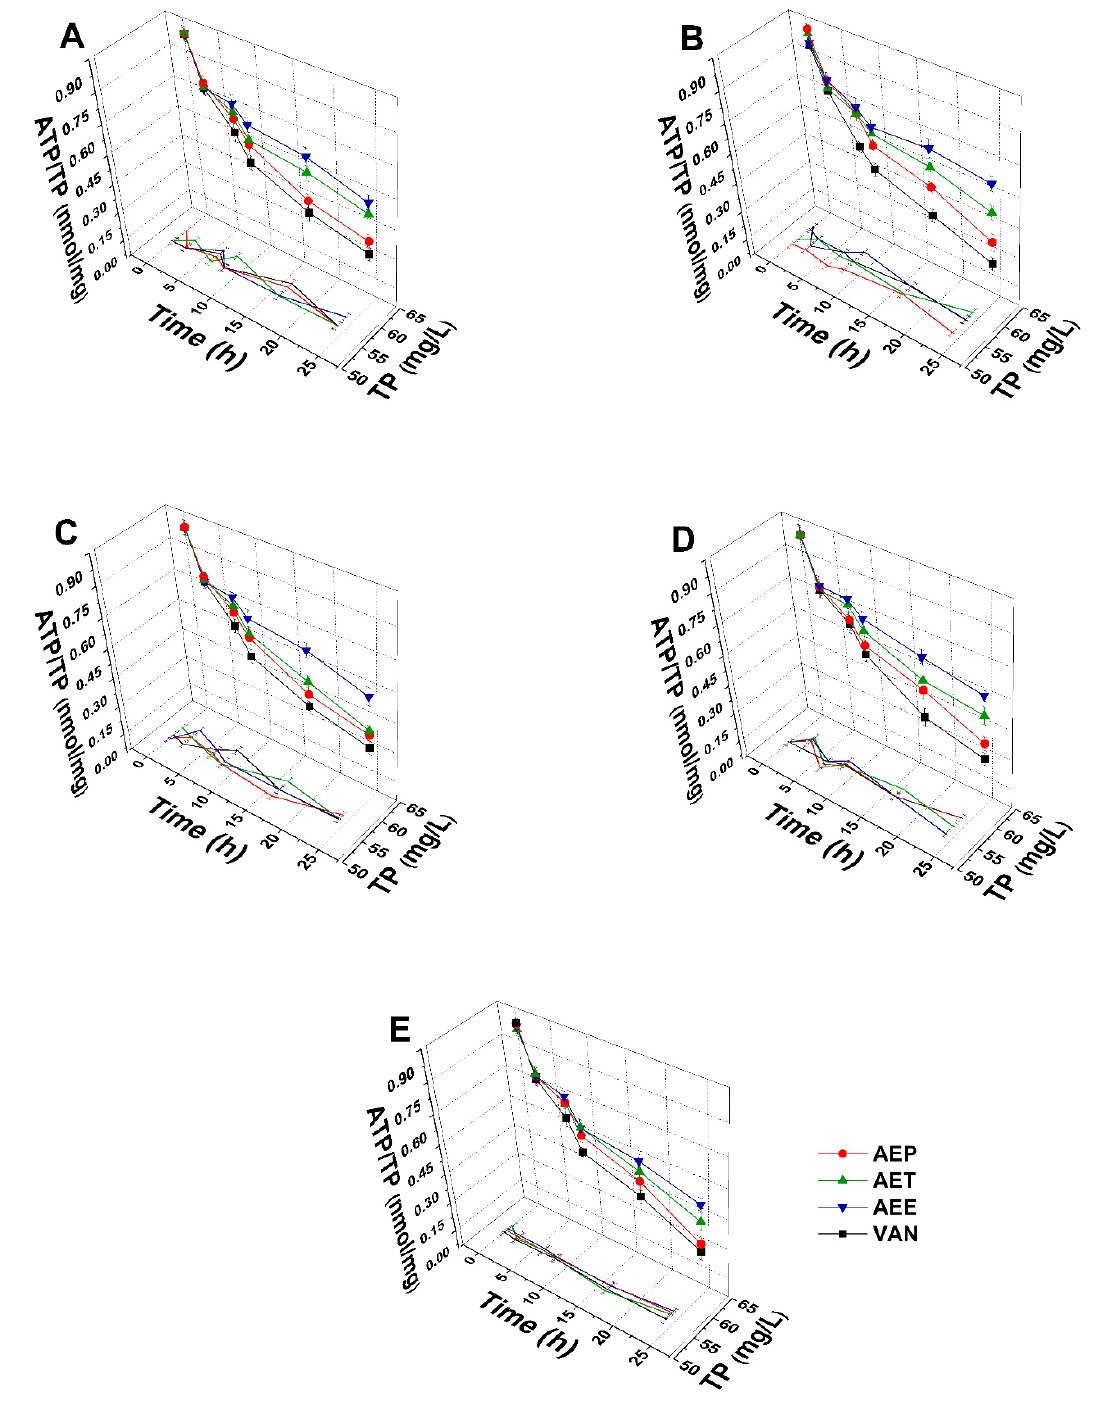
Figure 11. Effects of AEP, AET and AEE at their MEC 10 concentrations on the total protein content (TP) and intracellular ATP/TP ratio of the planktonic E. coli ( A ), S. aureus ( B ), B. subtilis ( C ), P. aeruginosa ( D ), and S. pyogenes ( E ) compared to their respective 0 h samples and vancomycin (VAN) standard antimicrobial controls after 2, 6, 8, 16 and 24 h of treatment (mean ± SD, n = 6 independent experiments each with three technical replicates).